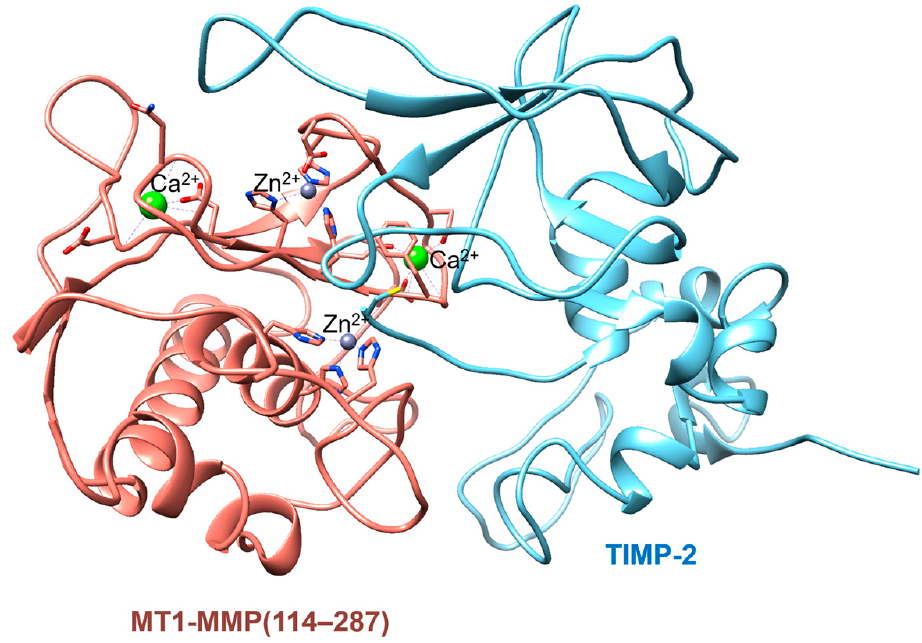
Figure 5. X-ray crystal structure of the catalytic domain of MT1-MMP (114–287) complexed with tissue inhibitor of metalloproteinase 2 (TIMP-2). The PDB code is 1BUV.